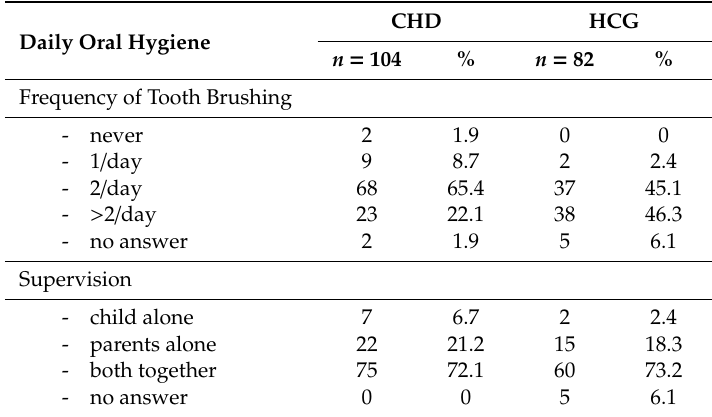
Table 2. Answers concerning the daily oral hygiene of the child with congenital heart disease (CHD) compared with the healthy control group